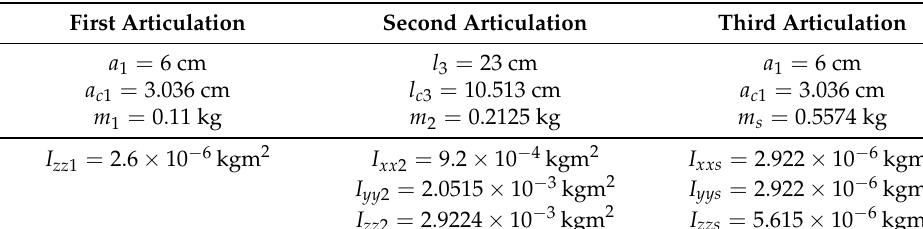
Figure 1. Diagram of the 6DOF manipulator. Table 2. Manipulator